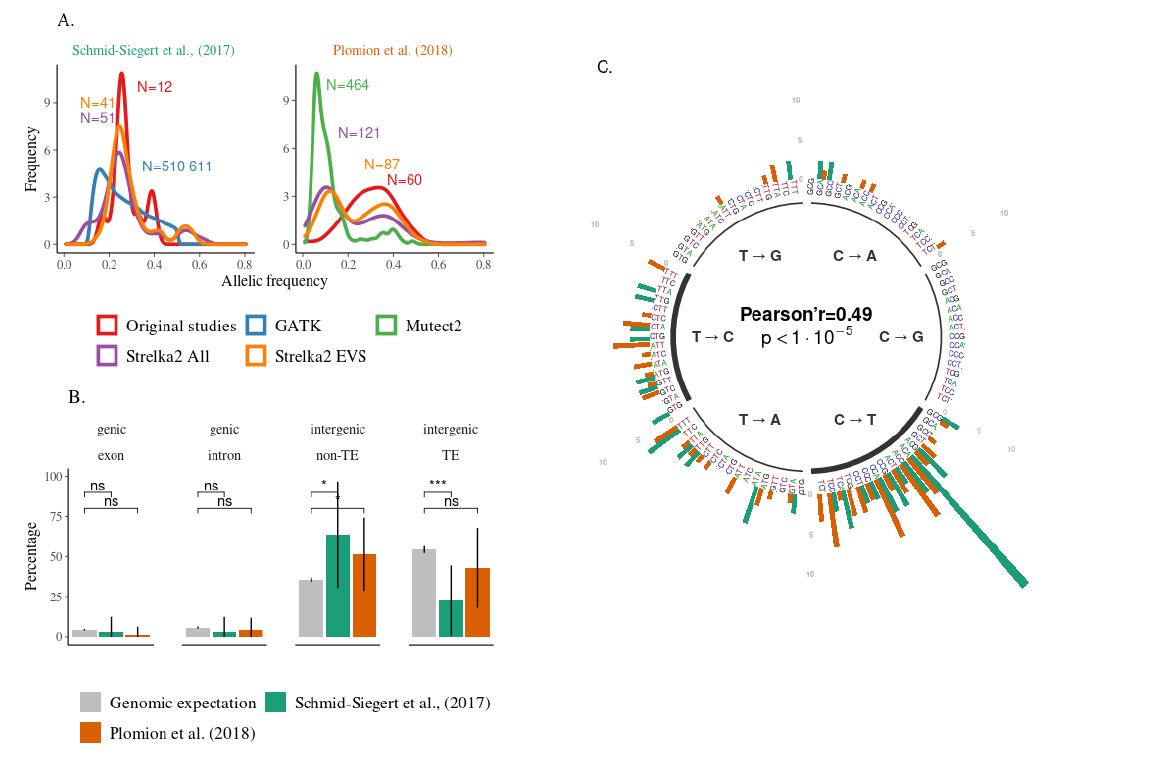
Figure 3: Candidate mutation spectra depending on variant callers and filtering in Schmid-Siegert et al., (2017) and Plomion et al., (2018). A . Allelic fraction distribution for every dataset, including the candidate mutations from the original article present in the raw data from the reanalysis (red), the results of GATK with Best Practices (blue), Mutect2 after filtering (green), and Strelka2 after filtering (purple), and the results of Strelka2 using the filtering based on empirical variant scores named EVS (orange). The labels indicate the number of candidate mutations in each dataset. Per caller comparisons are available in Fig. S7. B . Annotation of the mutations detected by Strelka2 across chromosomes using the filtering based on empirical variant scores named EVS for Schmid-Siegert et al., (2017, green) and Plomion et al., (2018, orange) compared to the genomic expectation (grey, see Supplementary Note S1). Error bars represent the standard deviation (SD) of the observed percentages across chromosomes,